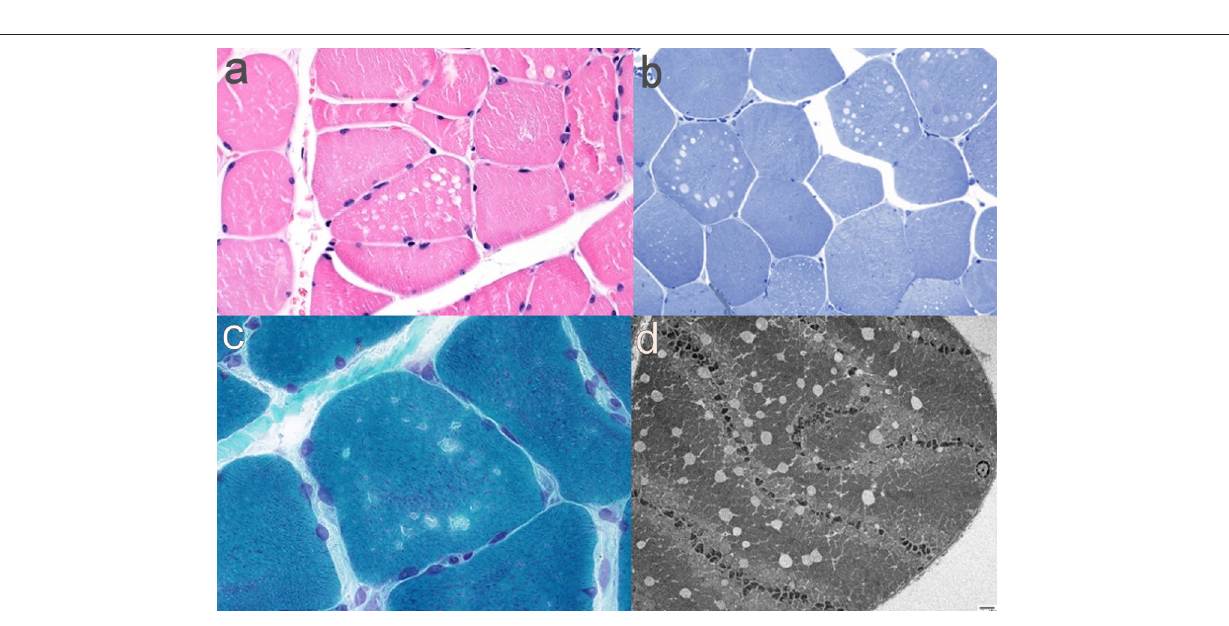
went on to have a reoccurance of rhabdomyolysis off statin therapy. His maximum CK levels were 4,021, 4,568, and